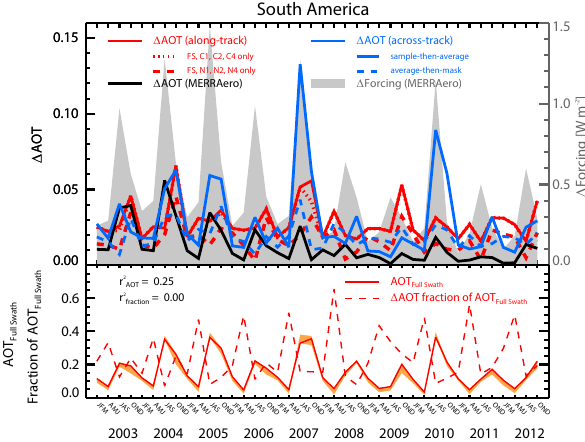
Figure 10. As in Fig. 9, but for the Indo-Gangetic